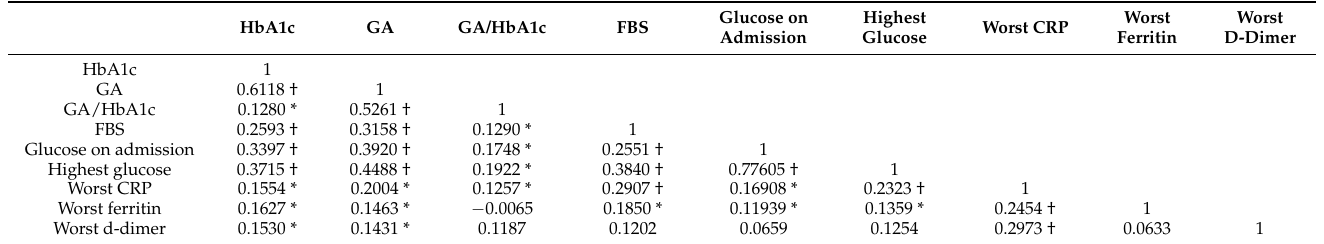
Table 2. Kendall Tau correlations of glucose control status and inflammatory markers with